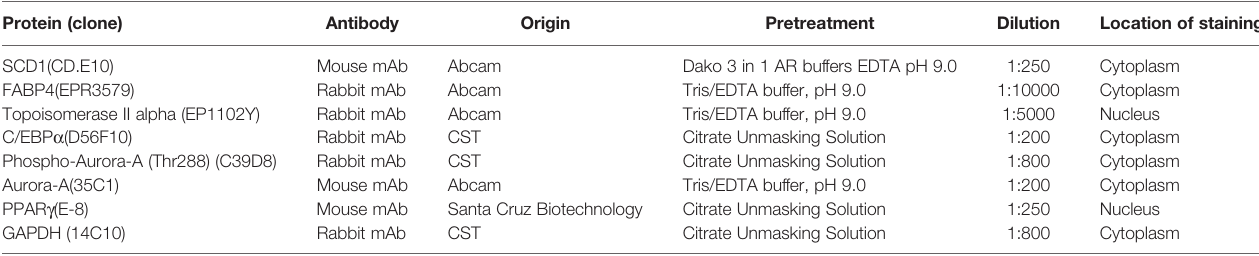
mAb-monoclonal antibody.